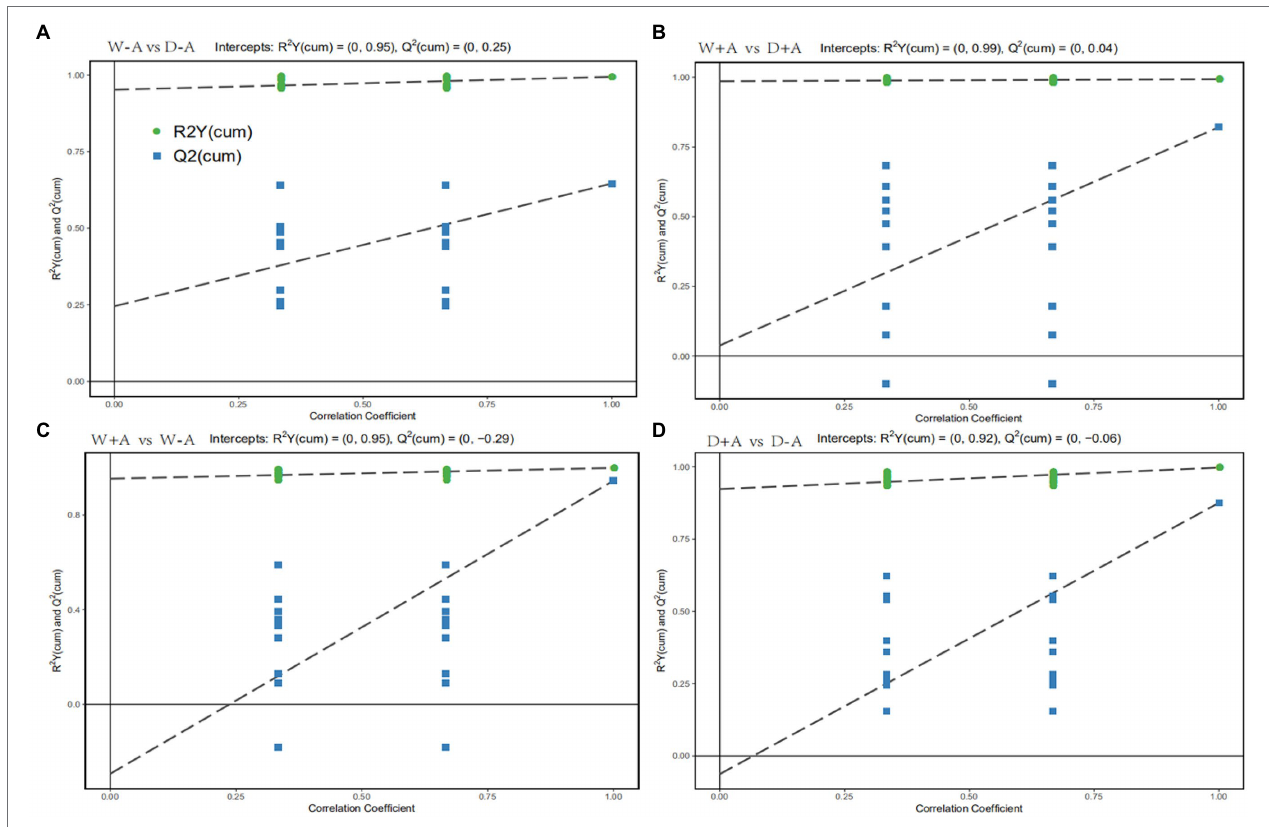
FIGURE 3 | OPLS-DA of metabolites in roots of trifoliate orange seedlings under well-watered and drought stress conditions after inoculation with Rhizophagus intraradices . Abbreviation: W + A, inoculation with R . intraradices under well-watered conditions; W-A, inoculation without R . intraradices under well-watered conditions; D + A, inoculation with R . intraradices under drought stress conditions; D-A, inoculation without R . intraradices under drought stress conditions; mix, quality control